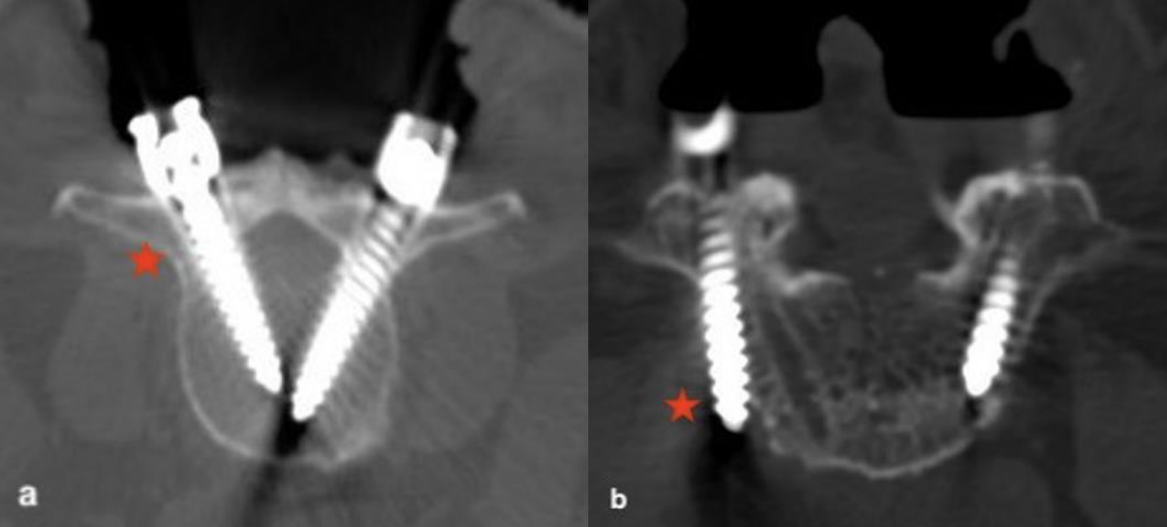
Figure 3. Unaccepted screw (red star) was defined as ( a ) a medial pedicle breach of >3 mm or ( b ) a lateral pedicle or body wall breach of >3 mm.